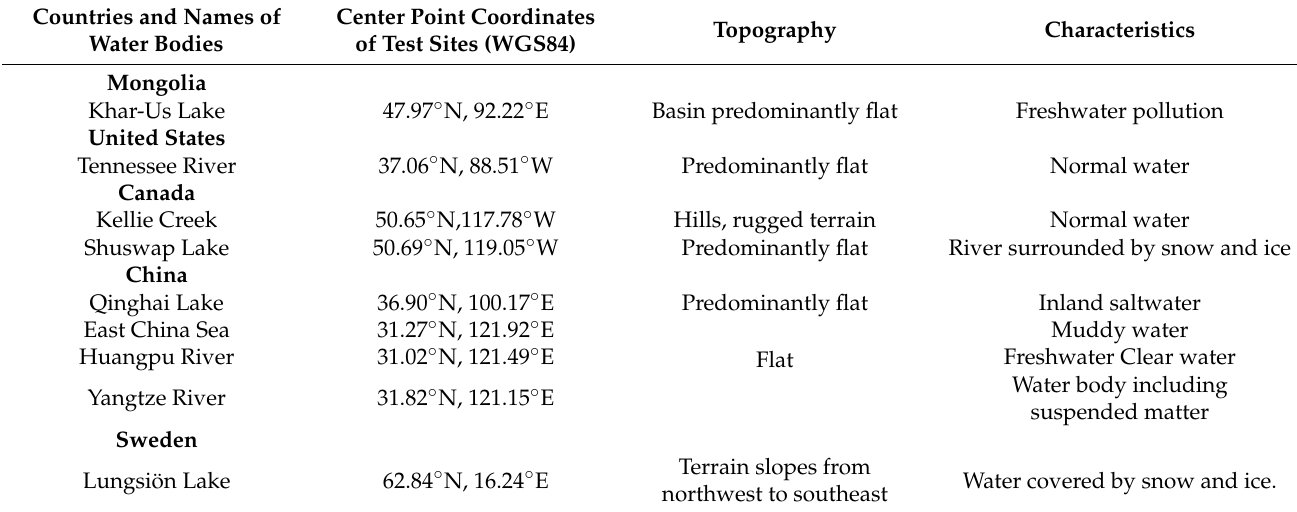
Table 1. Locations of studied water bodies and their typical